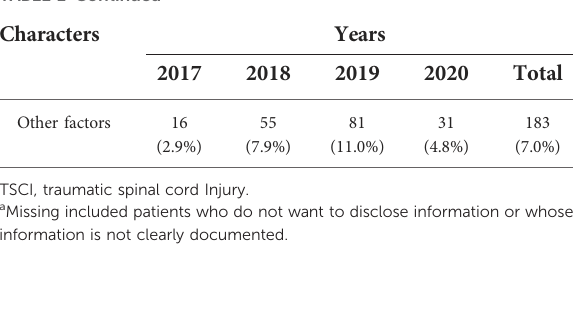
TABLE 1 Demographic and etiologic characteristics of patients with TSCI from 2017 to 2020.